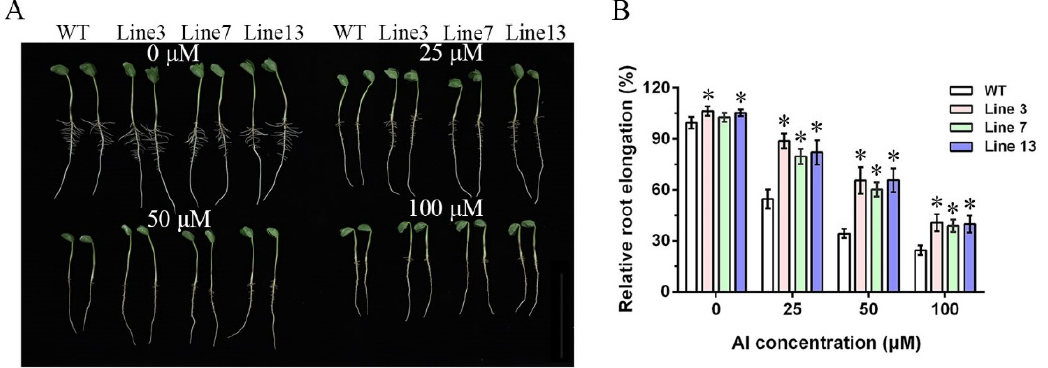
Figure 3. Short-term hydroponic phenotypic identification in wild type (WT) and transgenic lines under different AlCl 3 treatments. ( A ) Growth performance of WT and transgenic lines treated with 0, 25, 50 and 100 µ M AlCl 3 for 48 h. ( B ) Statistical analysis of relative root elongation in WT and transgenic lines treated with 0, 25, 50 and 100 µ M AlCl 3 for 48 h. Relative root elongation (%) = root elongation of different lines in different treatments/root elongation of WT in treatment with 0 µ M AlCl 3 * 100%. WT: wild type (Guixia1, Al-sensitive). Line 3, Line 7 and Line 13: GmWRKY81 transgenic lines. Asterisks denote significant differences: p < 0.05. The data are presented as the means ± SD from three biological replicates, and each biological replicate included 4